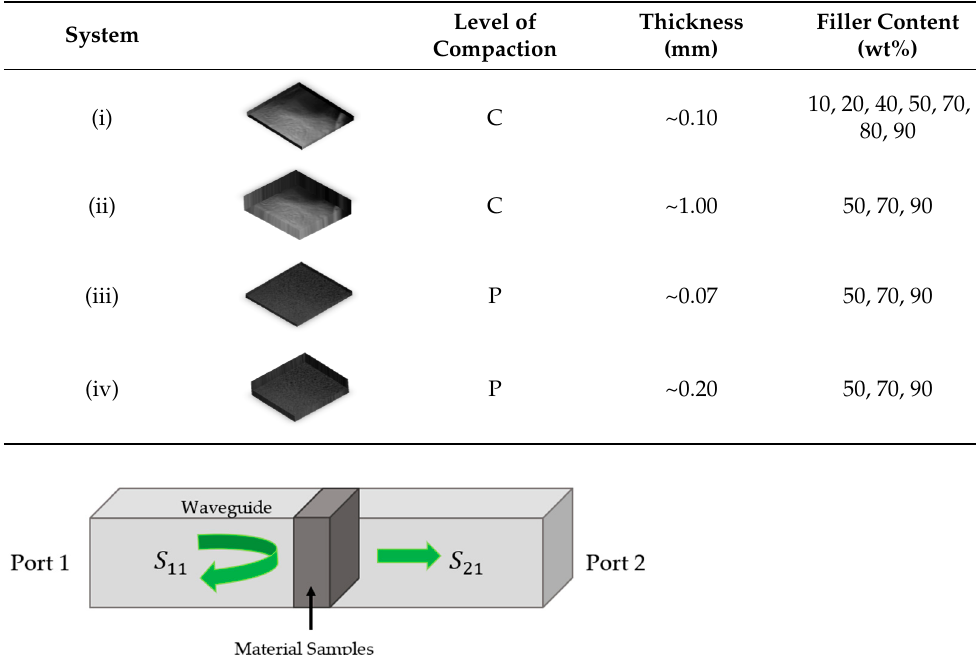
Figure 1. Manufacturing process: Step (1), dispersion and mixing of GNP particles in acetone with epoxy; Step (2), spray deposition of GNP/polymer/acetone mixture; Step (3), calendaring. Table 1. List of tested materials: C = compact; P = porous. System